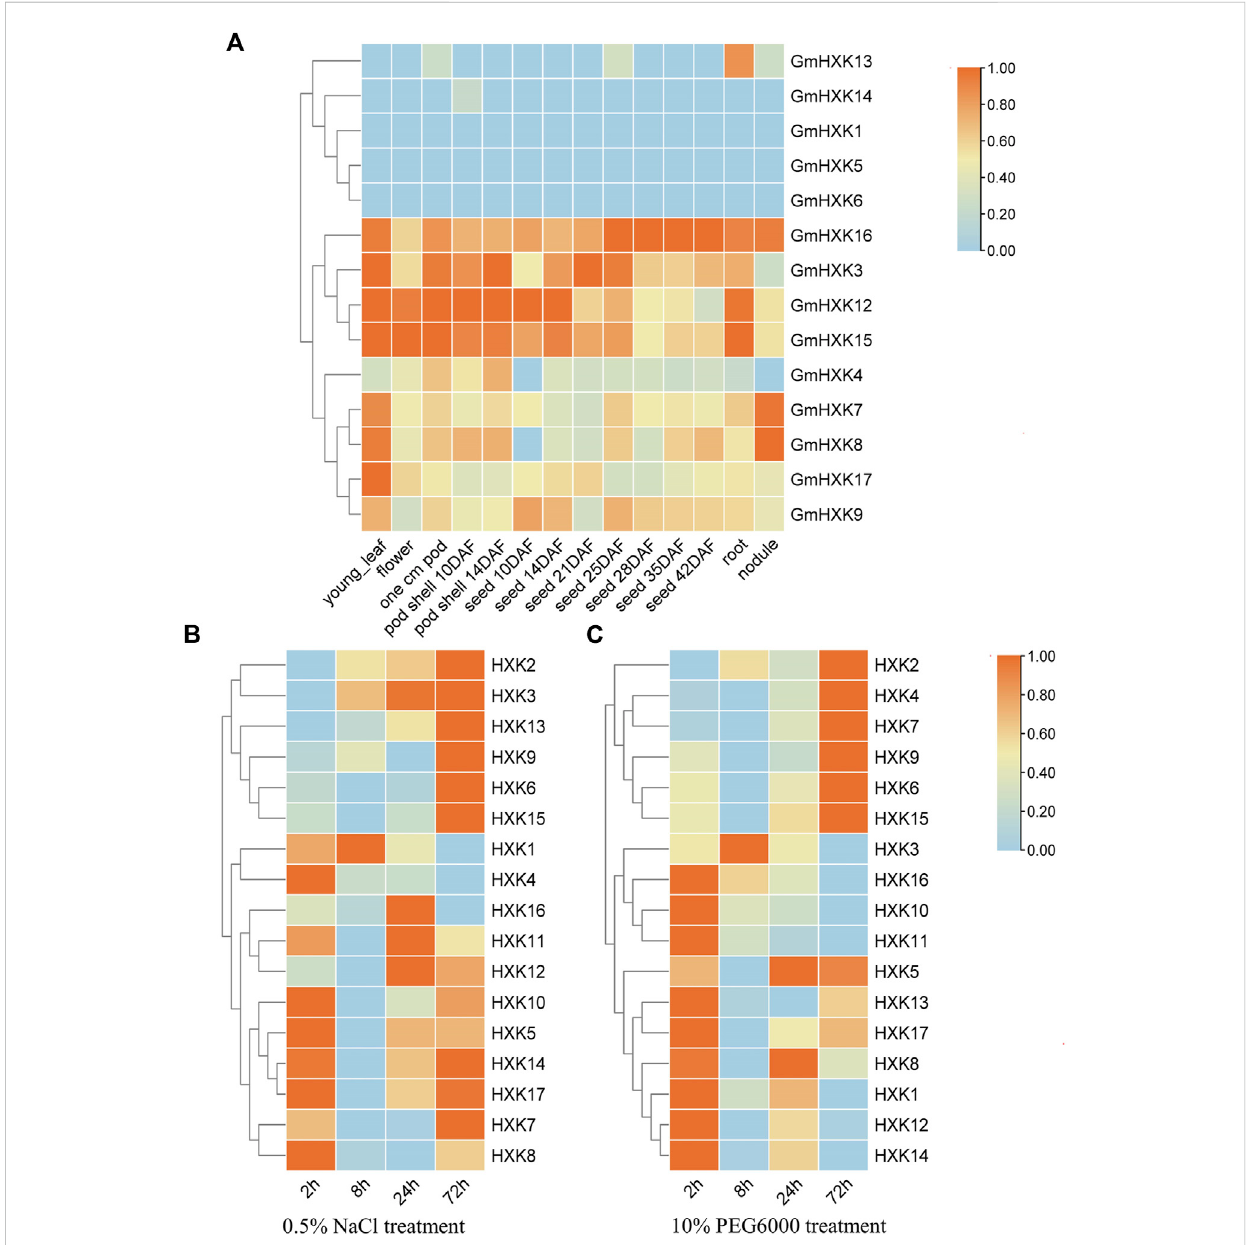
FIGURE 4 The expression pattern of GmHXK gene family. (A) . Tissue-speci fi c expression pro fi le of GmHXK under normal condition. Expression of GmHXK in roots under salt stress (B) and drought stress (C) . Data are presented as mean ± SE. Red indicates high expression levels blue indicates low expression